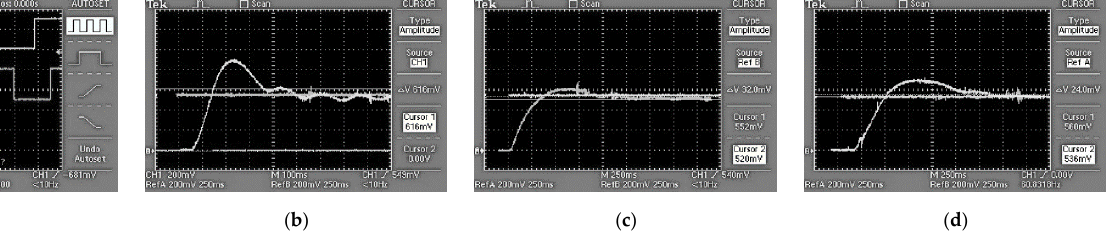
Figure 16. Overshoot Transient behavior with different controllers (Experimental). ( a ) 72 deg hall